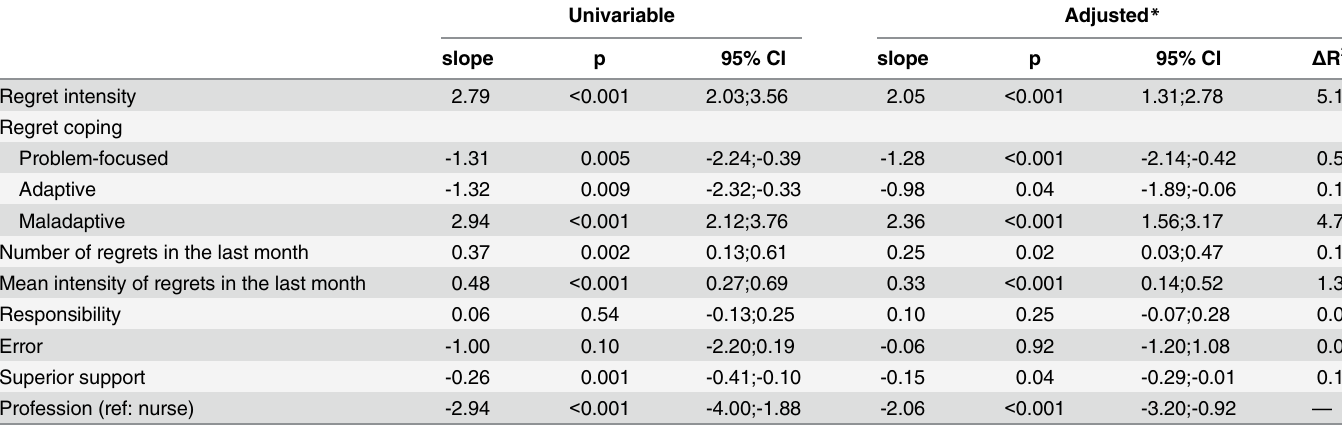
Table 2. Parameter Estimates and 95% Confidence Intervals from Linear Regression Models to Evaluate the Association Between Measures of Regret and Insomnia Severity Index Score.